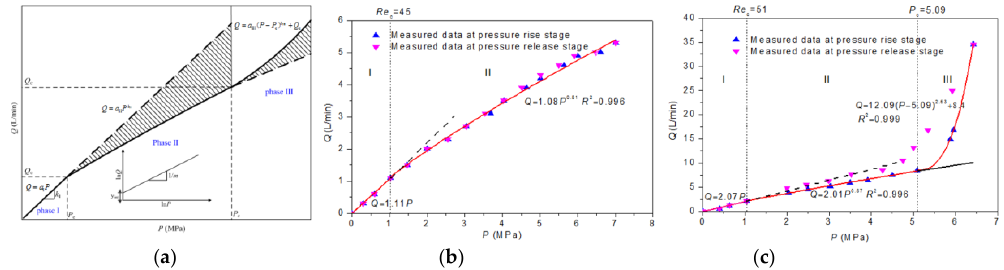
Figure 8. Types and features of P–Q curves in drilled borehole high-pressure Parker tests [59]: ( a ) Typical P–Q curve; ( b ) curve Type A; ( c ) curve Type B.